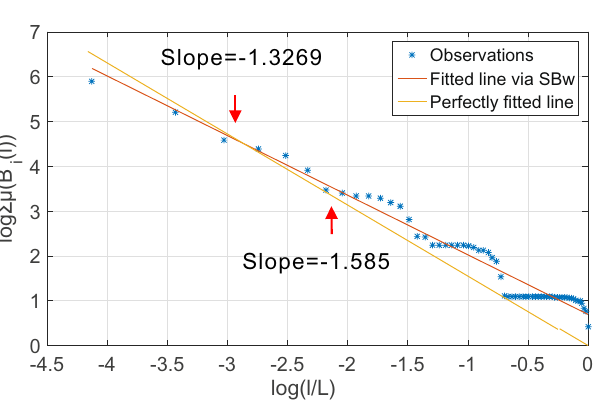
Figure 5. Observation of staircase effect in determination of dominant fractal dimension of G 4 of Sierpinski fractal network family using BCANw.